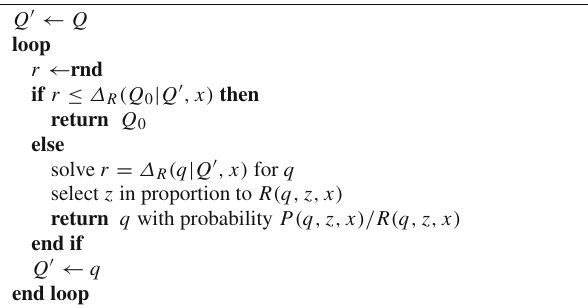
Algorithm 2 The weighted Sudakov veto algorithm